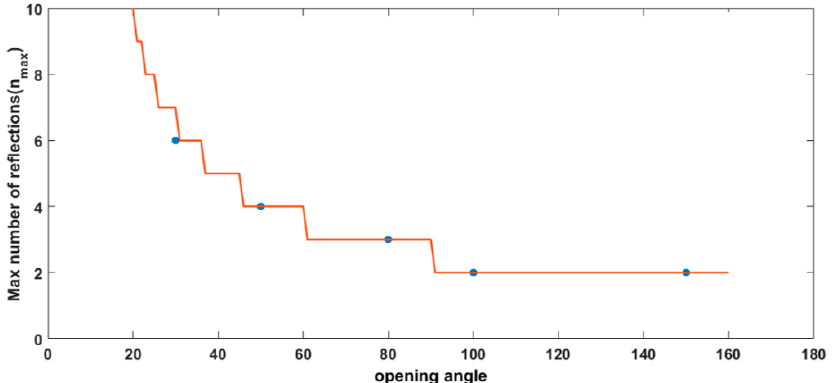
Figure 8. Maximum number of reflections as a function of the opening angle of the V-groove 𝜙 as computed from Equation (7) (—) and our ray tracing algorithm ( ● ).